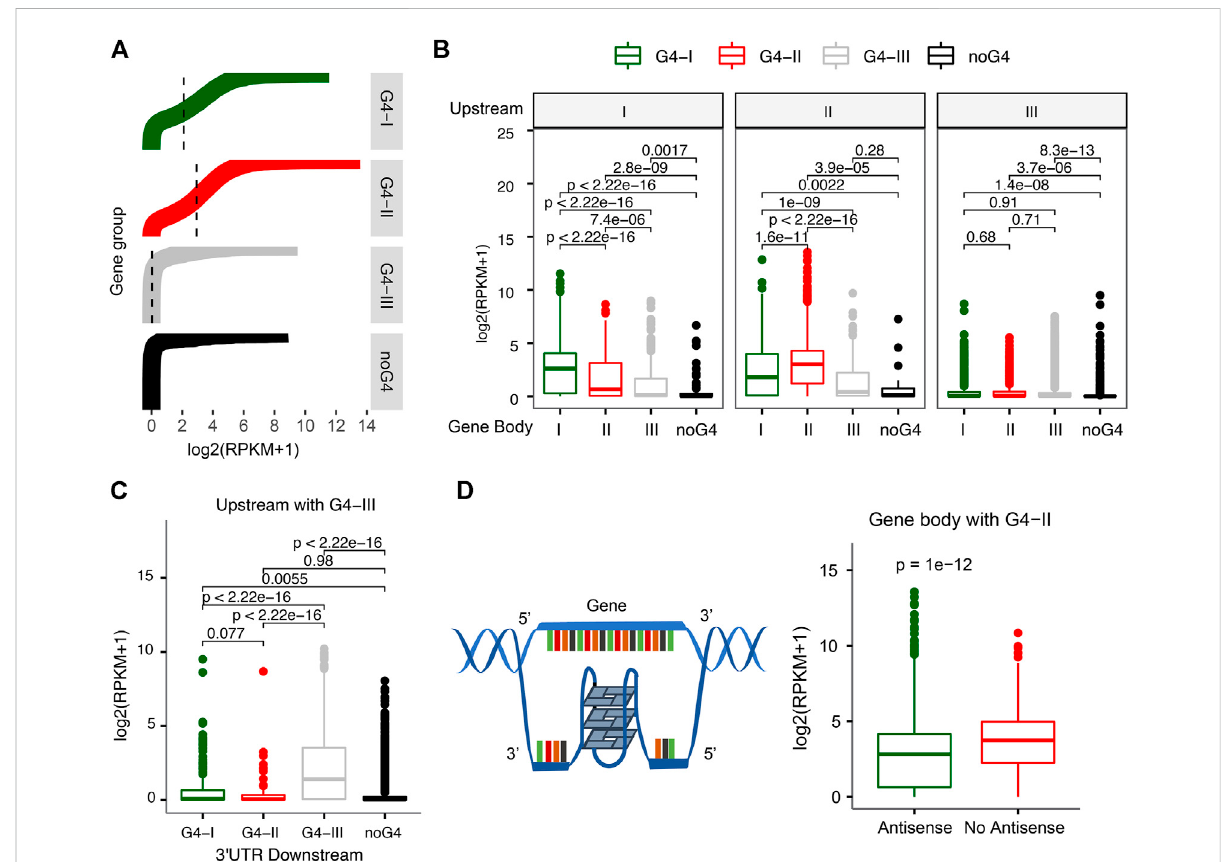
FIGURE 3 Relationship between gene expression and different G4 groups. (A) Distinct expression levels for genes with divergent G4 groups (G4-I, G4-II, andG4-III)orwithoutG4intheupstream. (B) DifferencesofgeneexpressionlevelswithG4combinationsbetweentheupstreamandgenebody. (C) G4-III in both upstream and 3 ′ UTR downstream leading to higher gene expression levels. (D) Decreasing expression levels for genes with G4-II on the antisense of gene